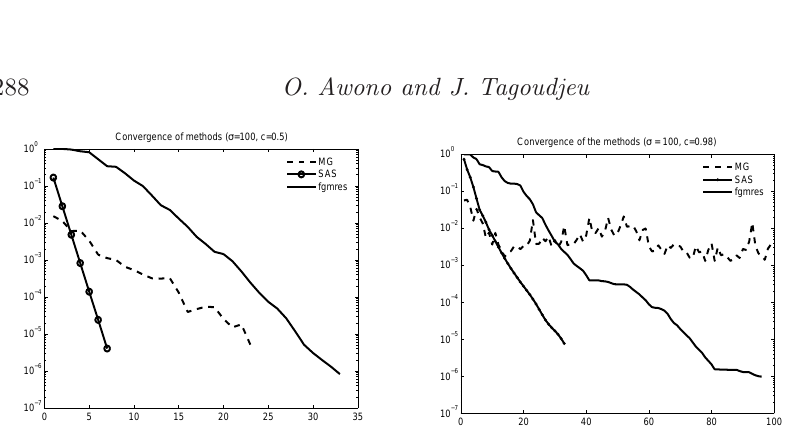
Figure 9. Convergence of the SAS, fgmres and MG ( c = 0 . 98 ) methods at fixed σ = 100